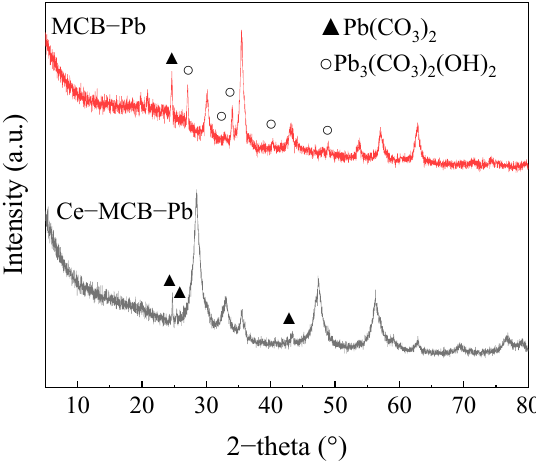
Figure 18. XRD patterns of MCB-Pb and Ce-MCB-Pb.